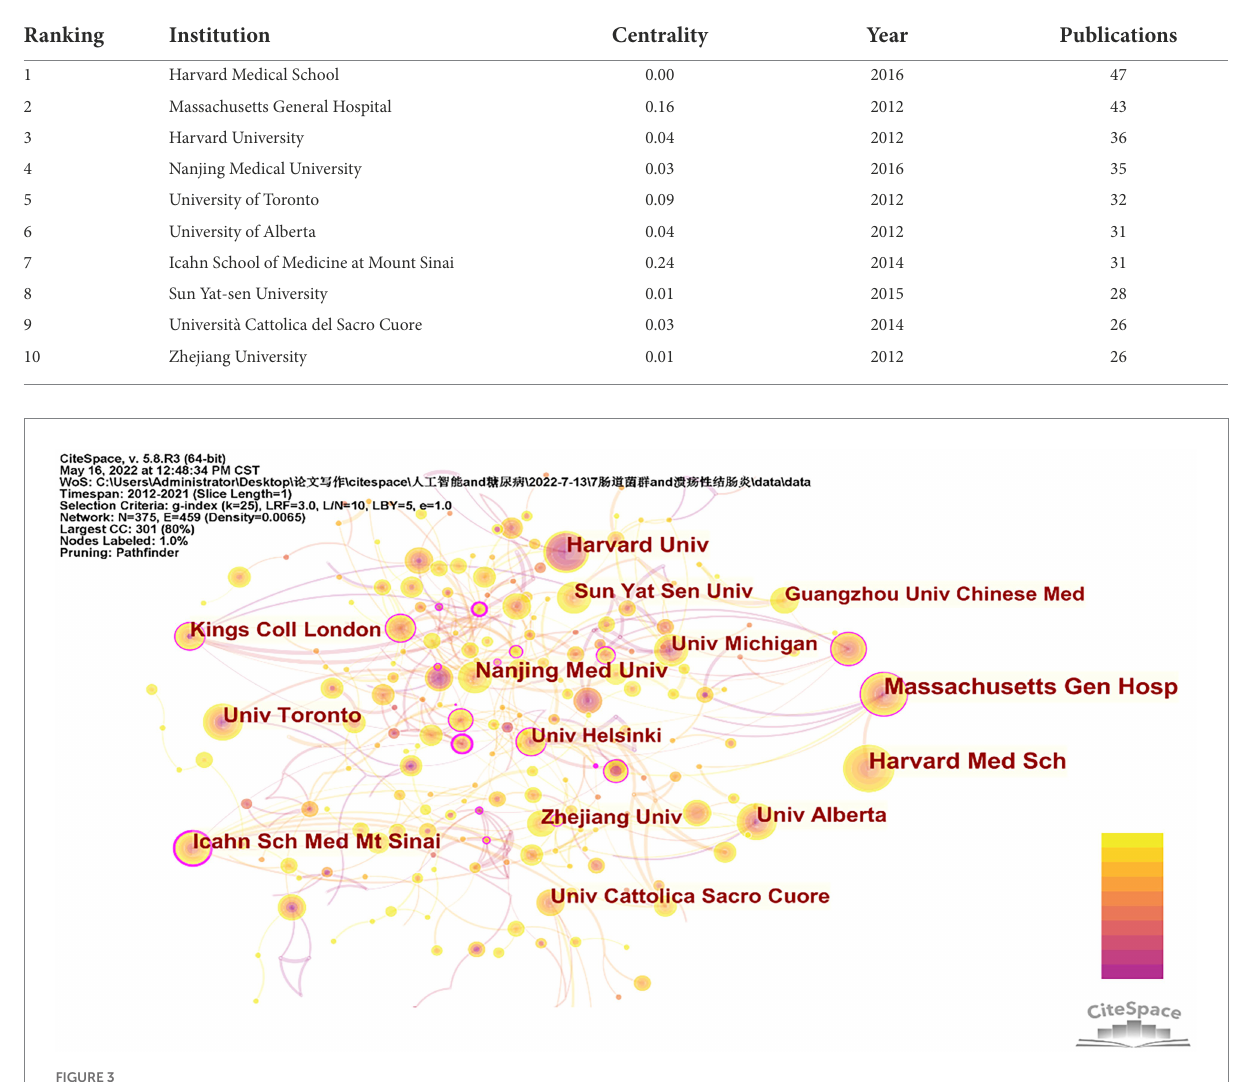
FIGURE 3 Institutional cooperation network.